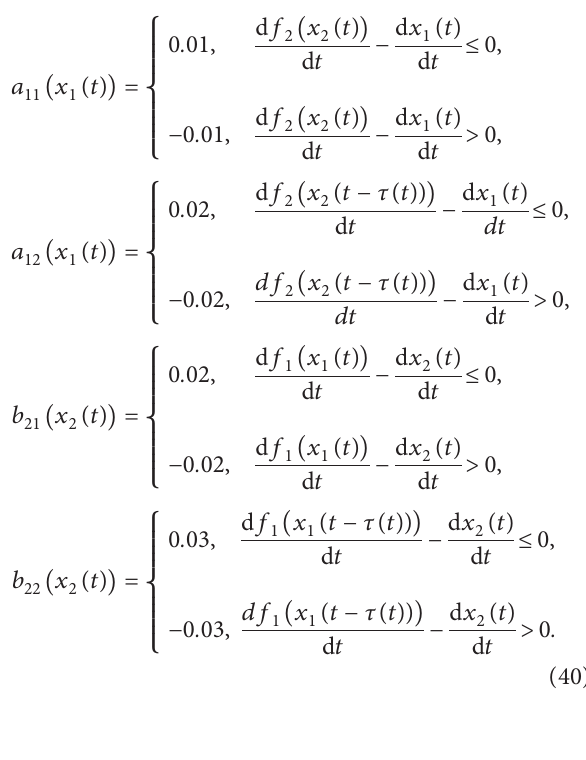
( t ) ,x ( t ) of system 1 2